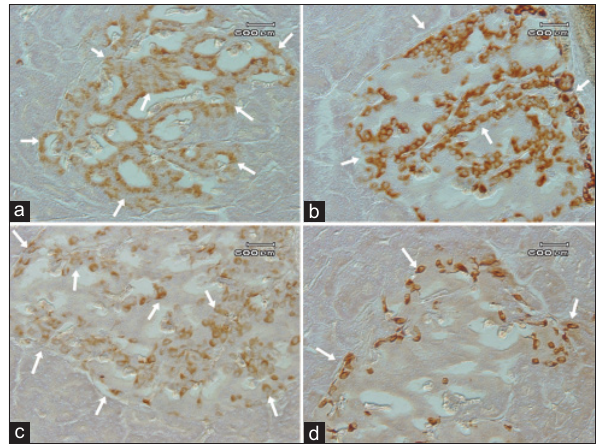
Figure-1: The insulin, glucagon, somatostatin and PP cells in the pancreatic islets of the Sunda porcupine. Insulin cells were demonstrated in the central and mantle regions (a), glucagon cells were mainly detected in the central and peripheral regions (b), somatostatin cells were dispersed throughout the whole central, mantle and peripheral regions (c), and PP cells were demonstrated in the central, mantle and peripheral regions (d) of pancreatic islets as indicated by arrows.